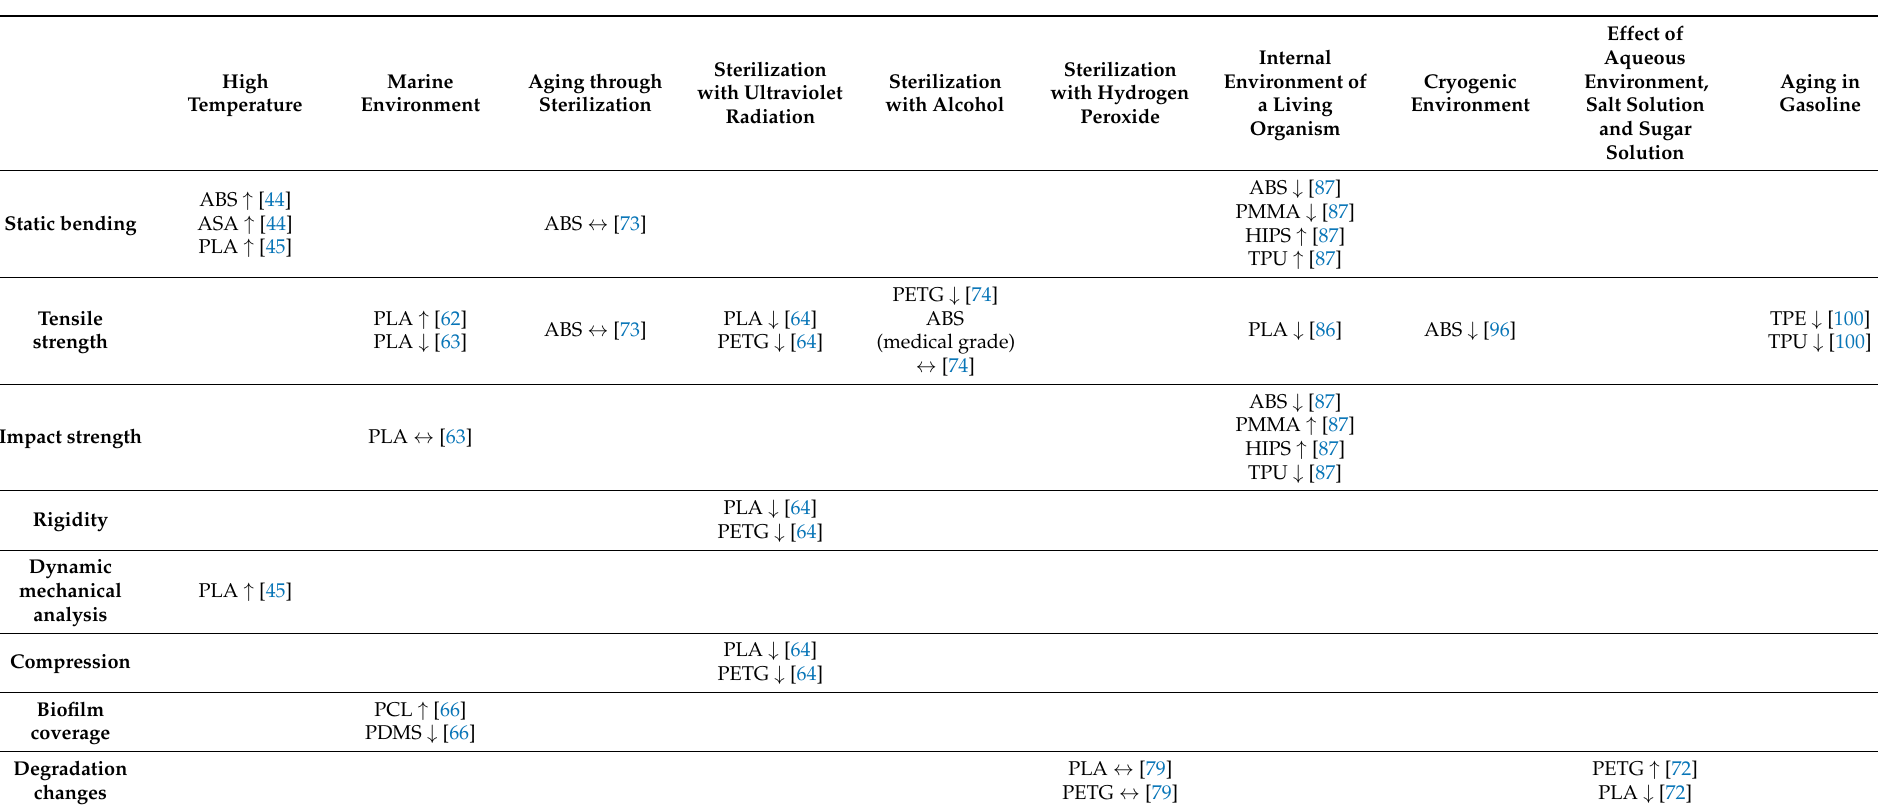
Table 1. Influence of the discussed environments on specific material